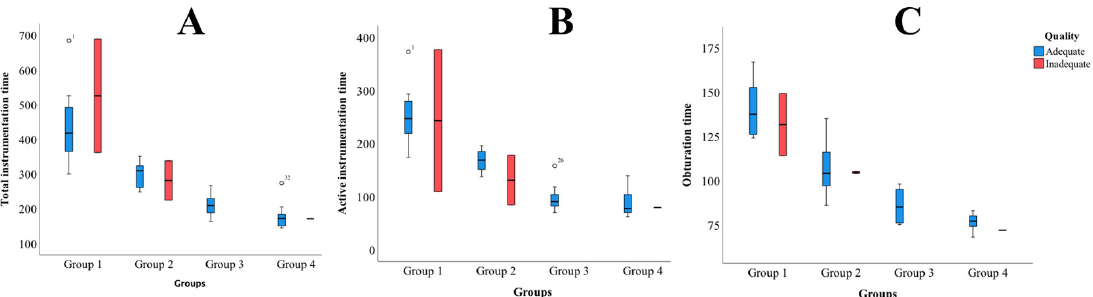
Figure 4. Multiple comparisons between treatment time and quality per group, by preparation or- der. ( A )—Total instrumentation time; ( B )—active instrumentation time; ( C )—obturation time. (“ ◦ ”—outlier).